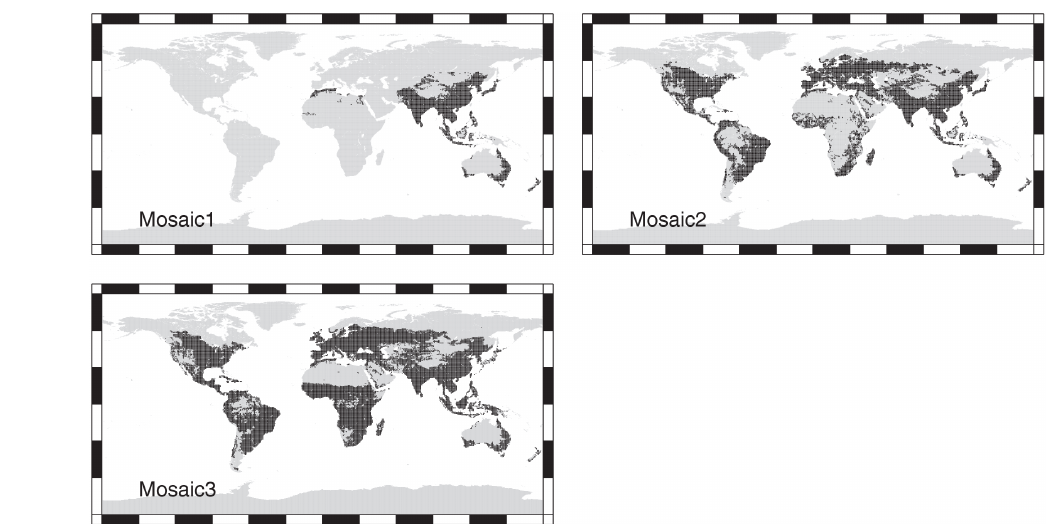
Figure 1. Geographical distribution of irrigated croplands – (a) double cropping each year (Mosaic 1), (b) single cropping each year (Mosaic 2) and (c) rain-fed cropland (Mosaic 3) – used in this study. The distributions are indicated in